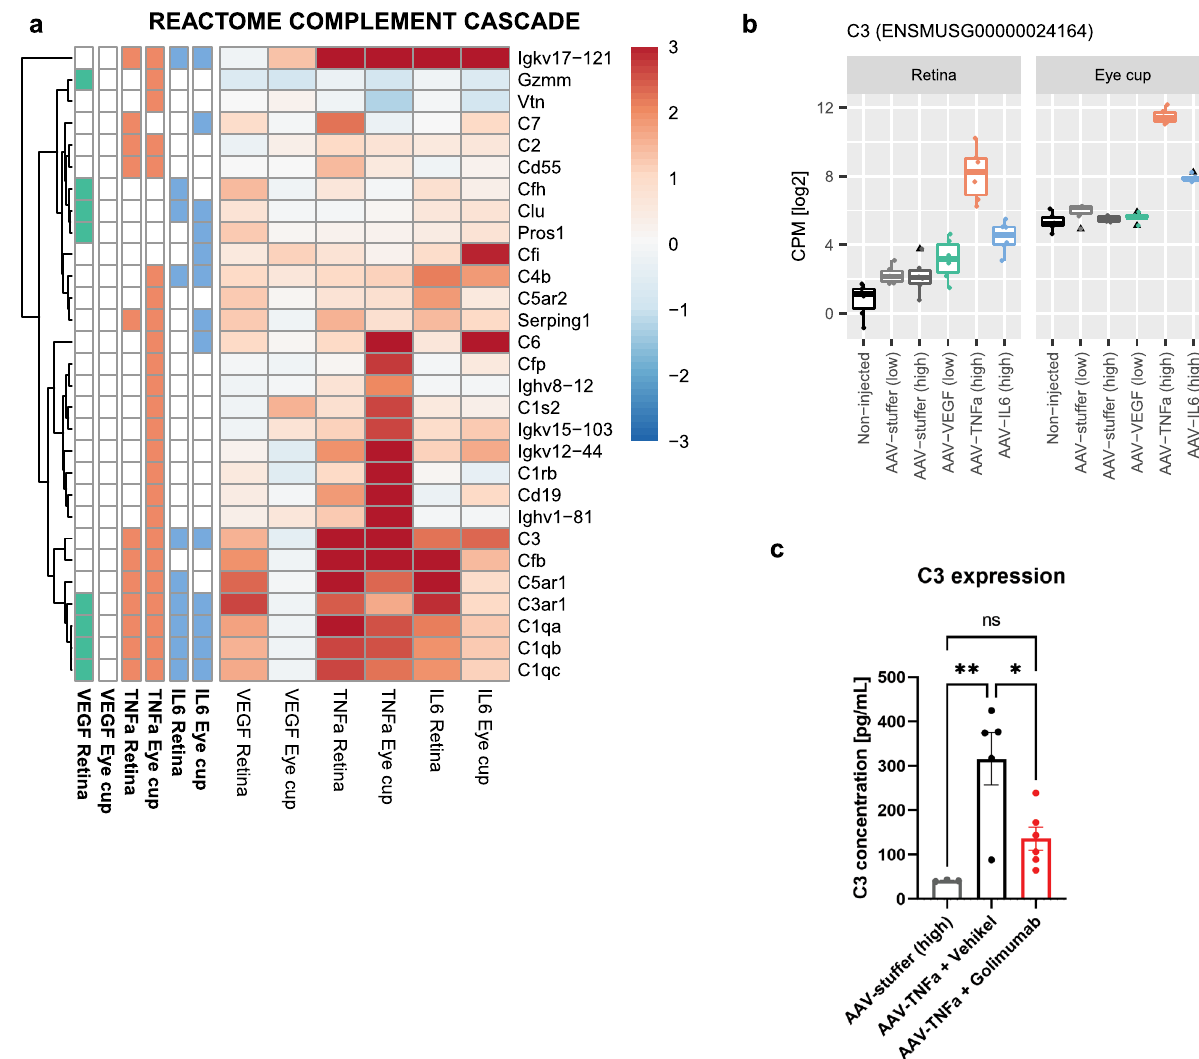
Figure 4. TNF-α induced a strong upregulation of the complement pathway ( a ) Upregulation of several members of the complement cascade pathway was observed especially in AAV-TNF-α transduced eye cup tissue. Colored squares in columns on the left indicate significant gene expression changes with an BH adjusted P-value < 0.05. ( b ) C3 expression was highly upregulated in AAV-TNF-α treated retina and eye cup. ( c ) C3 protein was also upregulated by AAV-TNF-α in an independent mouse cohort at 6 weeks after AAV-TNF-α treatment and this upregulation was partially rescued by anti-TNF-α treatment with golimumab (**p < 0.01; *p < 0.05, 1-way ANOVA with Tukey post-hoc test; n = 3–6) as measured by